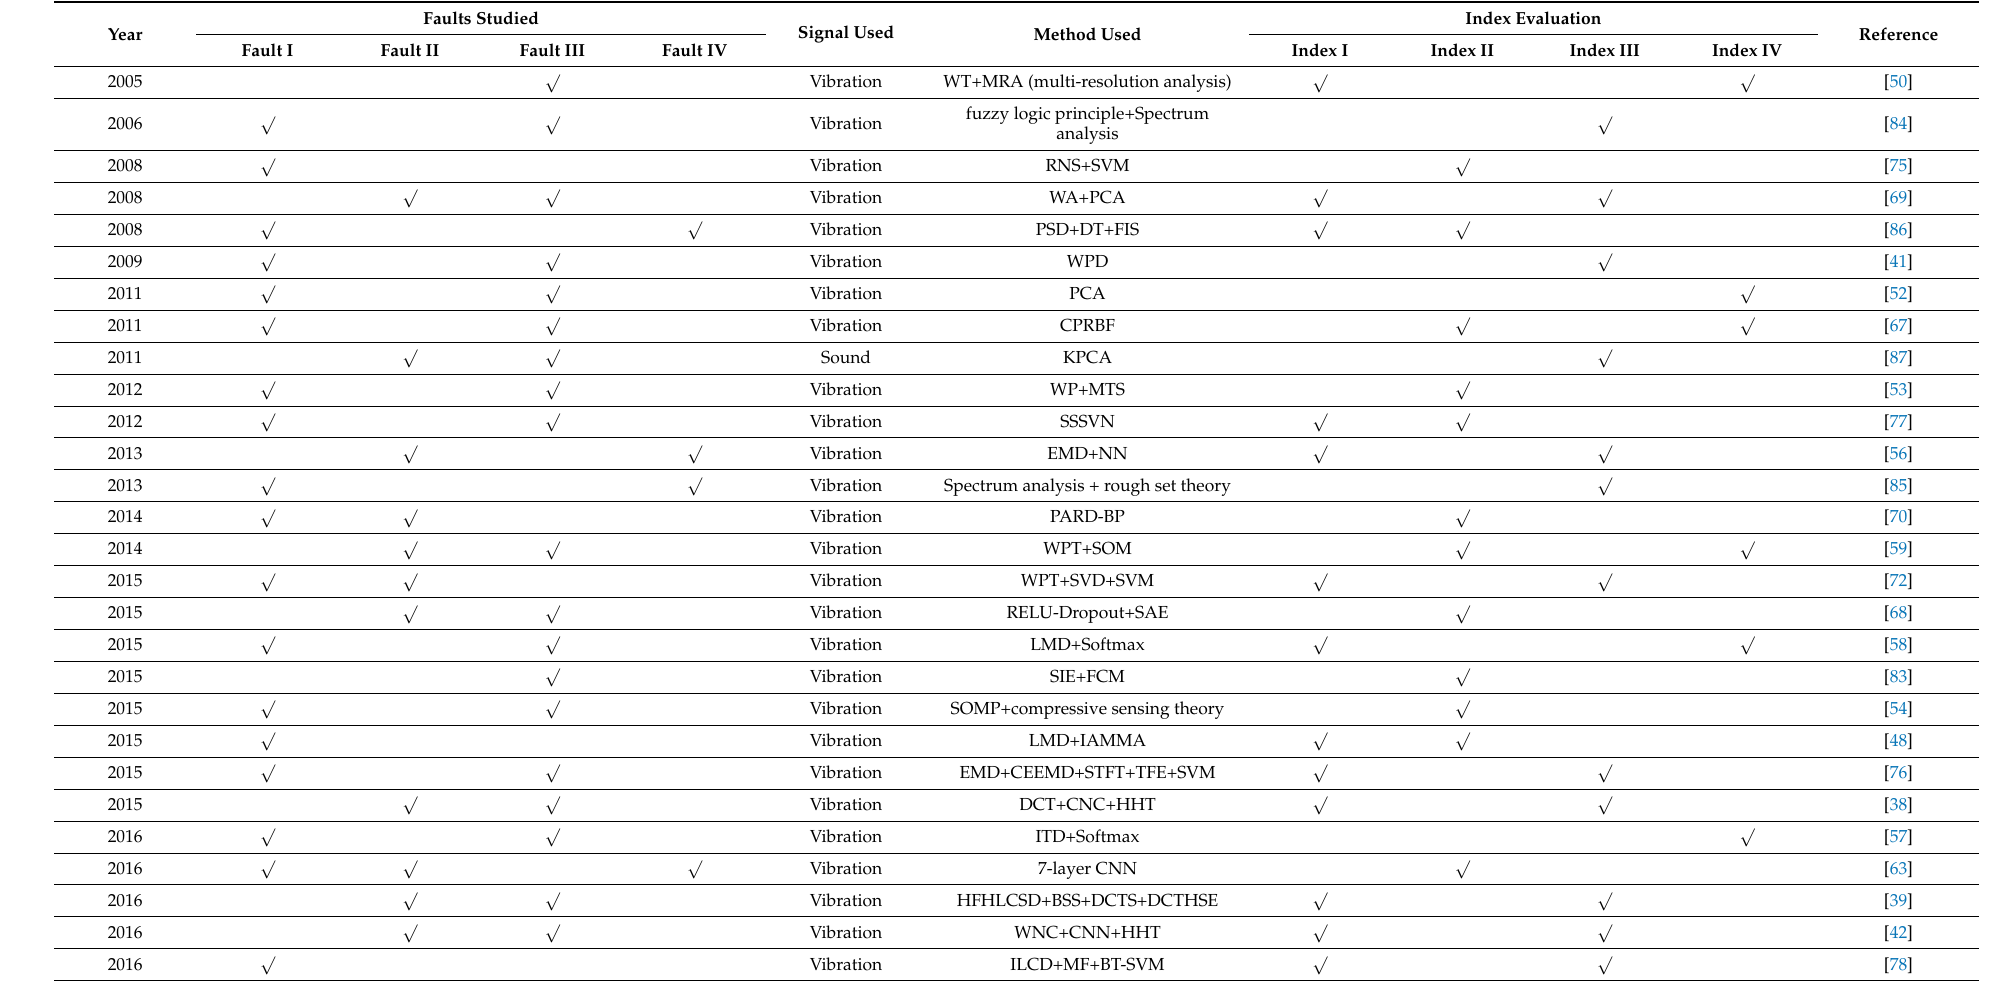
Table 2. Fault diagnosis method based on a single